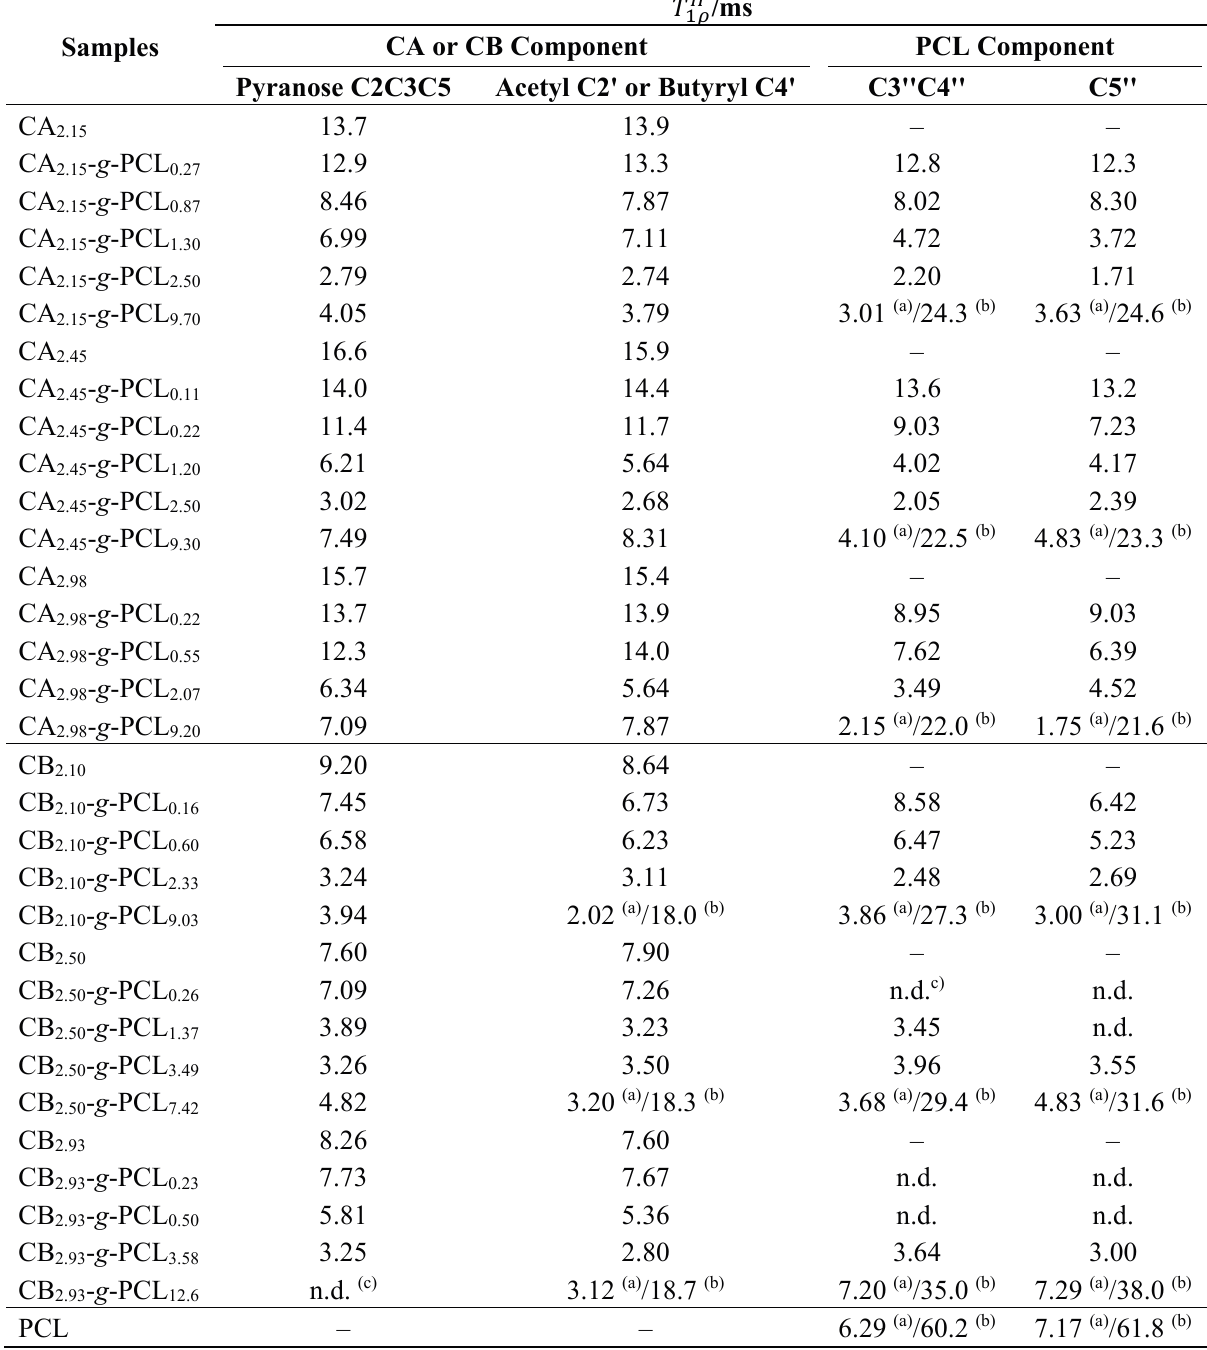
Table 1. (cid:1846) (cid:2869)(cid:3096)(cid:3009) data for CA, CB, PCL, and their graft copolymers. Reproduced with permission from ref. [55]. Copyright 2011 Elsevier